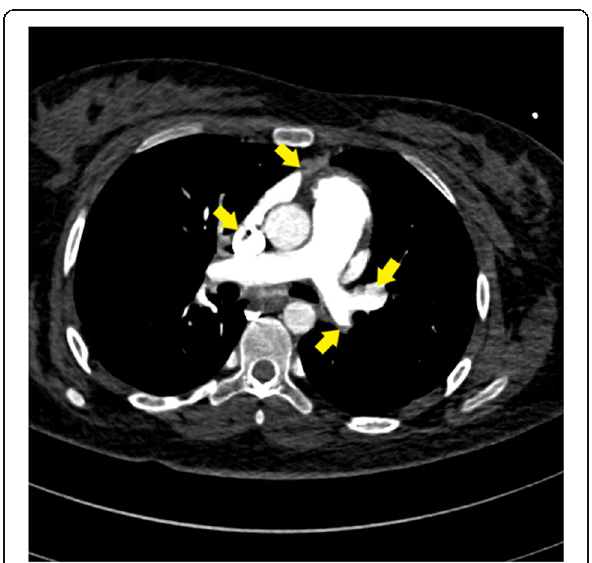
Fig. 5 Multi-slice CT pulmonary angiography showing normal major pulmonary artery branches with occluded some peripheral pulmonary branches